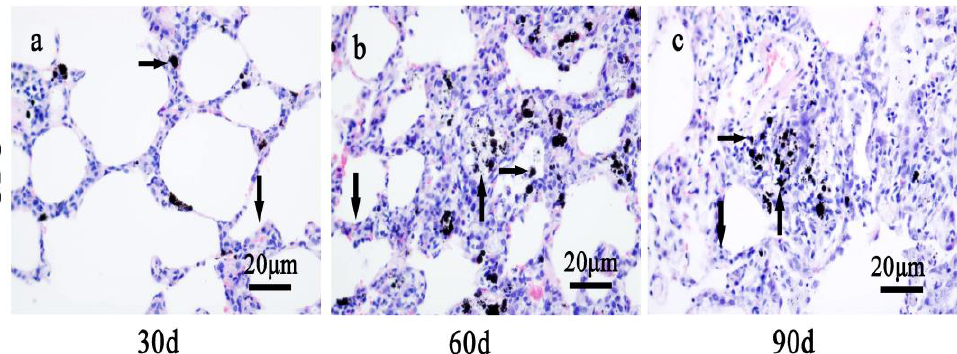
Figure 4. The alteration of lung tissue pathological morphology of SD rats after the repair strategy with OPC. ( a ) Oral administration of OPC for 30 days, ( b ) oral administration of OPC for 60 days, and ( c ) oral administration of OPC for 90 days. Black spots are CdSe nanorod-positive sites (right arrows), the lung tissues from OPC groups showed alveolar mucosa with slightly swelling (down arrows), relatively few nodular histiocyte hyperplasia (up arrows). The above typical pictures are selected from the lung tissues of eight rats in each group.